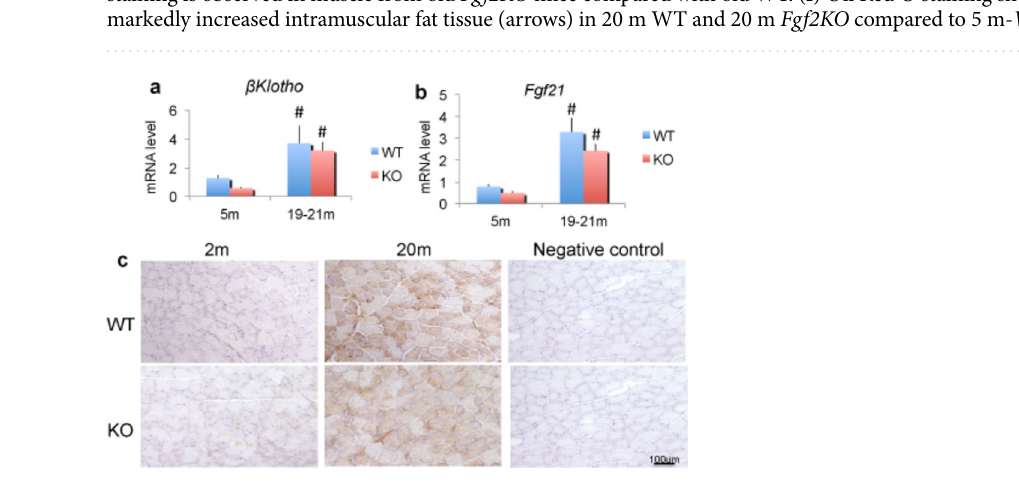
Figure 7. Expression of β-Klotho mRNA, Fgf21 mRNA and FGF21 protein in skeletal muscle from WT and Fgf2KO mice. Young (5 m) and old (20 m) WT and Fgf2KO mouse hindlimb gastrocnemius muscles were isolated and total RNA extracted for qPCR ( a ) β-Klotho mRNA; ( b ) Fgf21 mRNA were significantly increased in old muscle of both genotypes n = 4–6 mice/group. # Compared to corresponding 5 m p < 0.05 ( c ) Young (5 m) and old (20 m) WT and Fgf2KO mouse tibialis anterior muscles were isolated, sectioned and immunohistochemistry for FGF21 revealed increased FGF21 in muscle cells of old WT and Fgf2KO compared with young of both